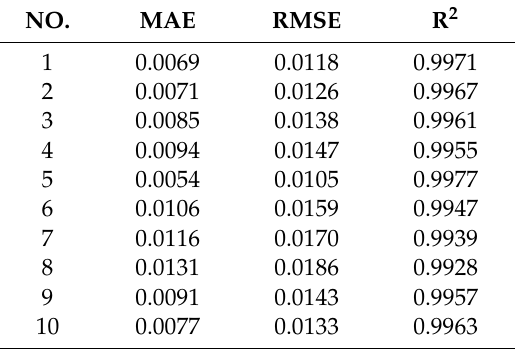
Performance index data of back propagation neural network (BPNN) sub–models (Validation set).